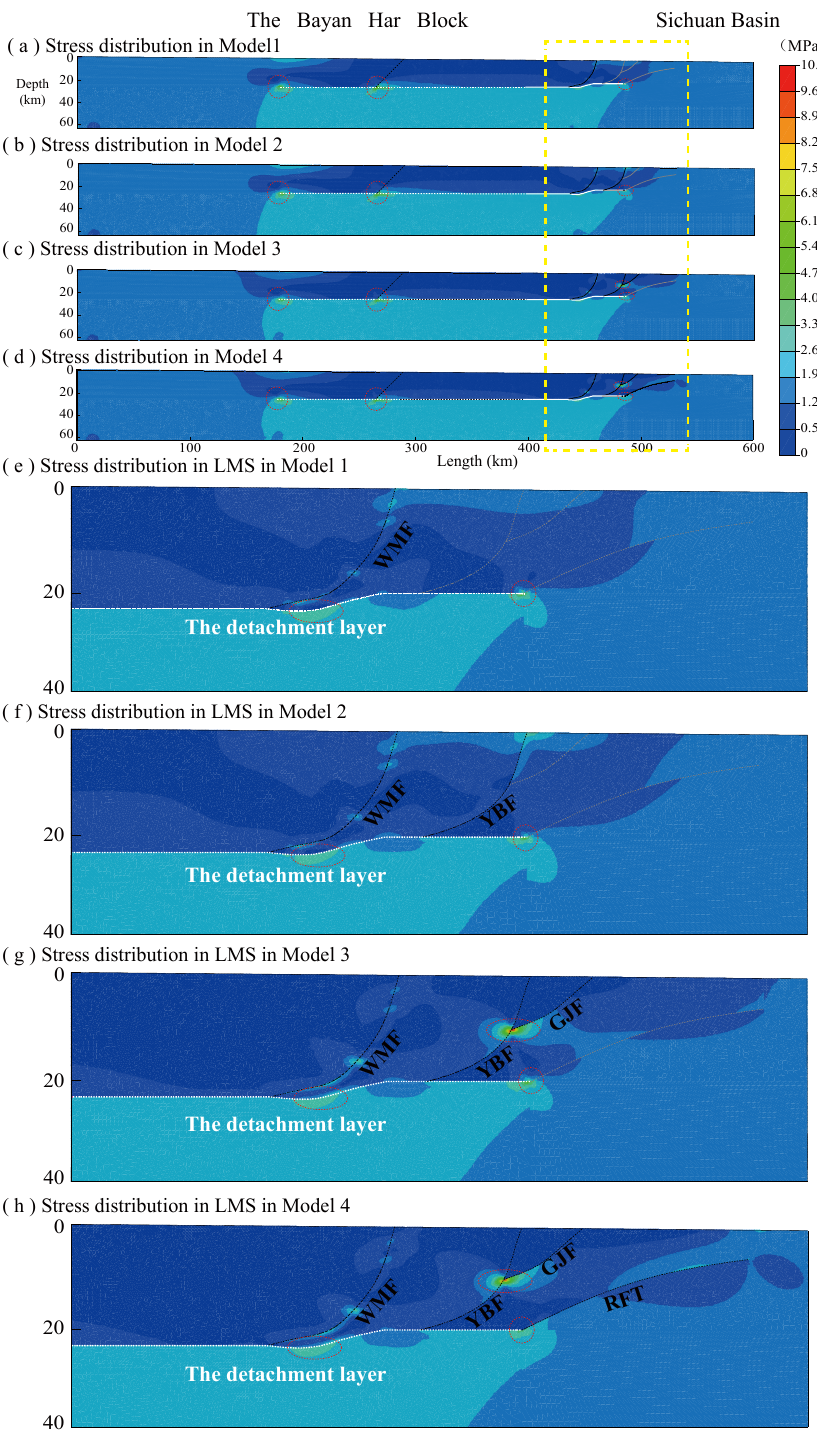
Figure 5. Distribution of cumulative equivalent stress. ( a – d ) are the entire model results from Model 1 to Model 4; Black dotted lines: Faults considered in the models; Gray dotted lines: Faults not considered in the models; White dotted line: The upper contact surface of detachment layer; Yellow dotted line: The enlarged area in the model; Red dotted line: High stress concentration area. ( e – h ) are the LMS results from Model 1 to Model